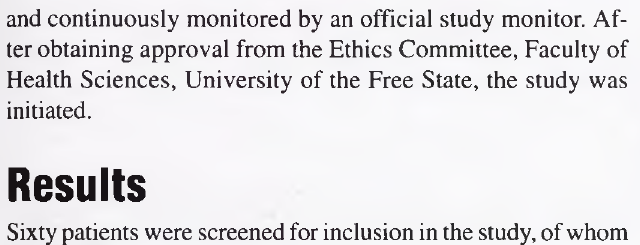
Table 1 : Base-line demographic